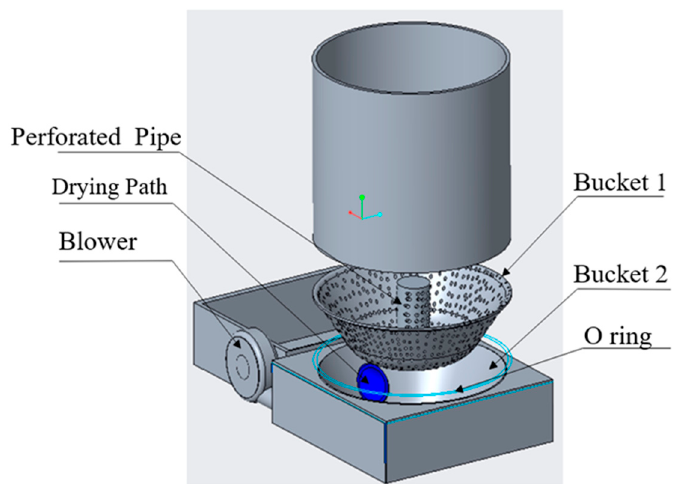
Figure 4. Schematic of the modified drying chamber.